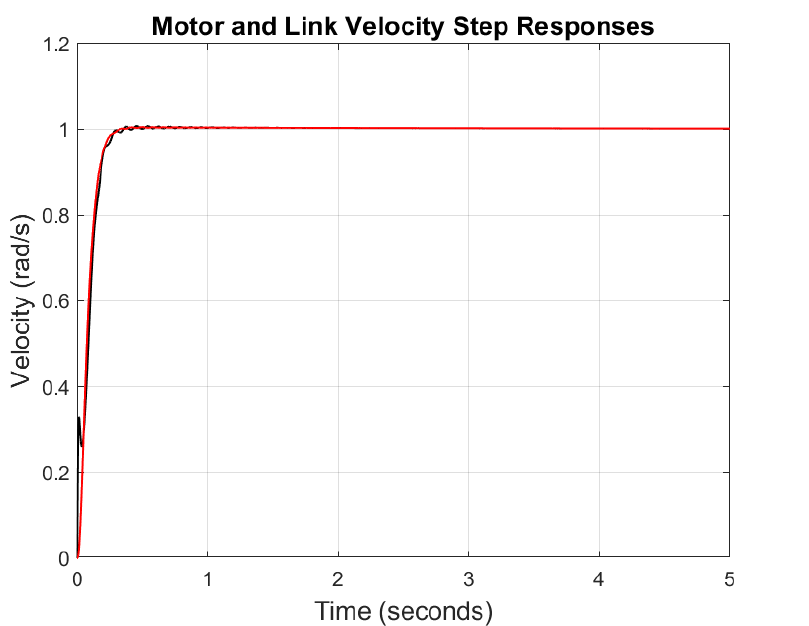
Figure 15. Motor and Link velocity time responses with variation in the link inertia—Black line: Motor Response; Red line: Link Response.